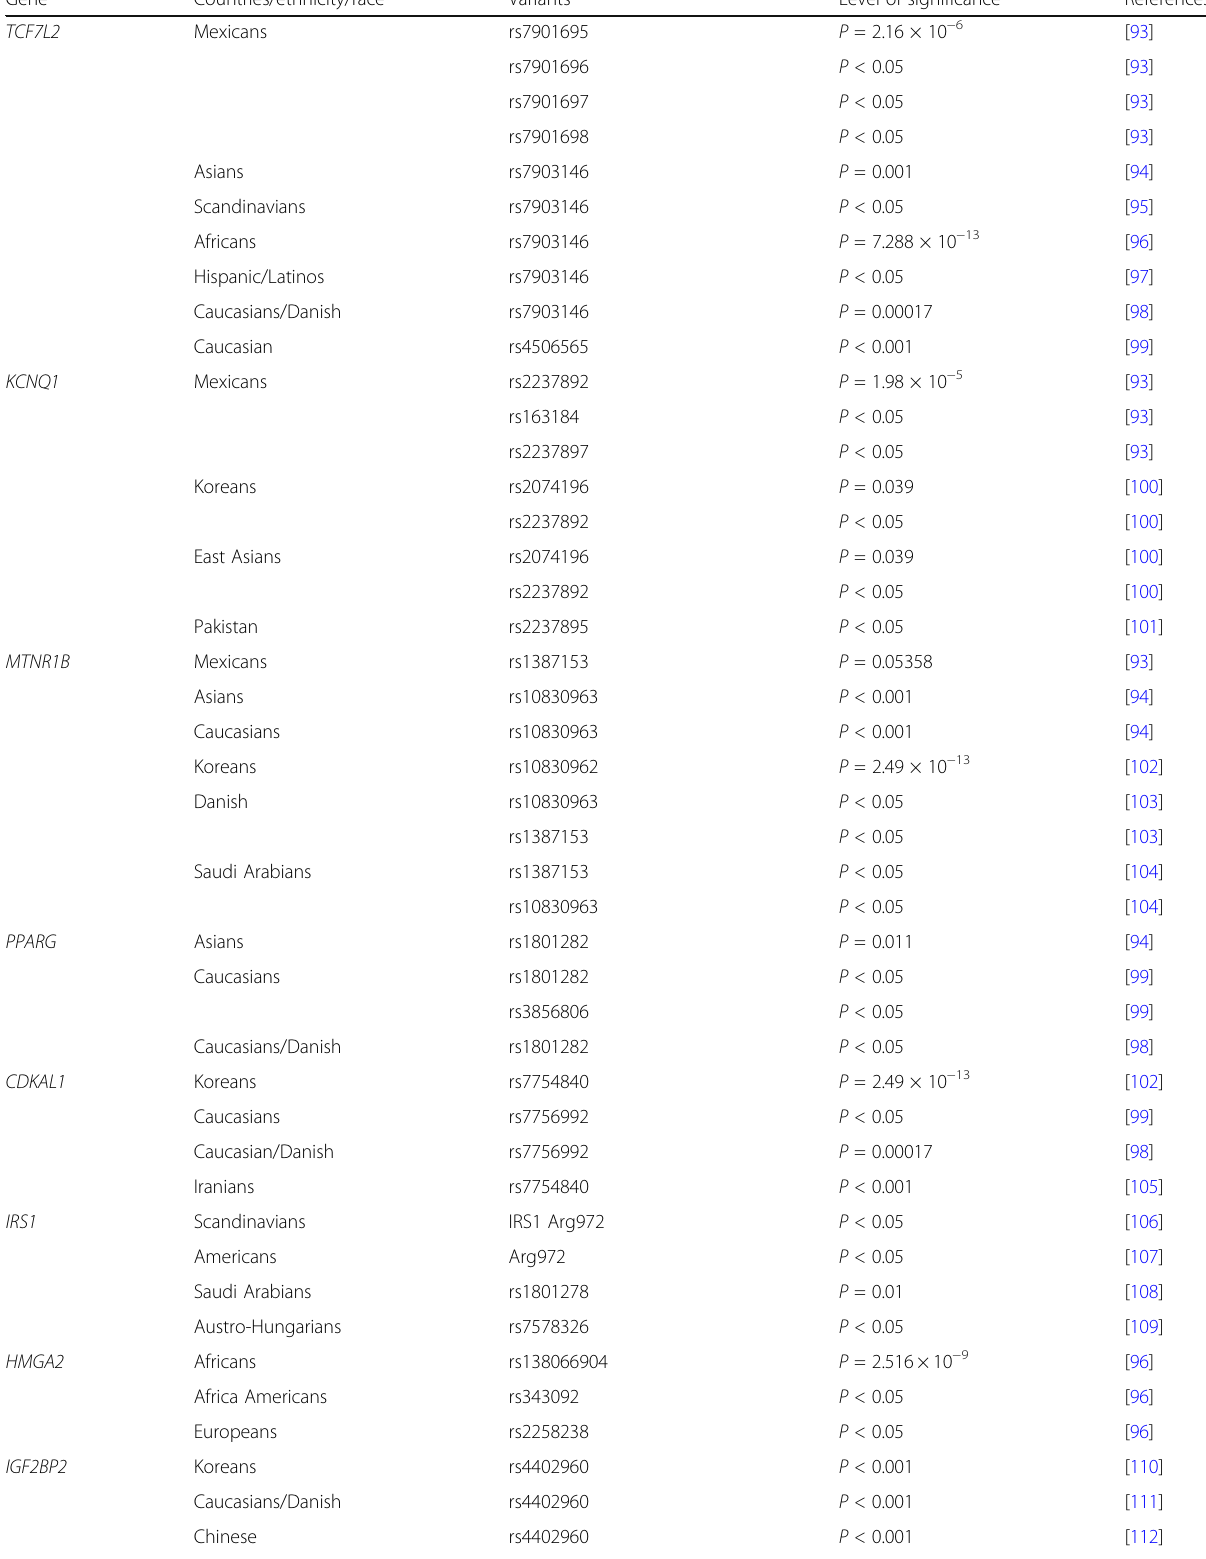
Table 2 Most prevalent gestational diabetes mellitus genes across countries, ethnicity, and race in the